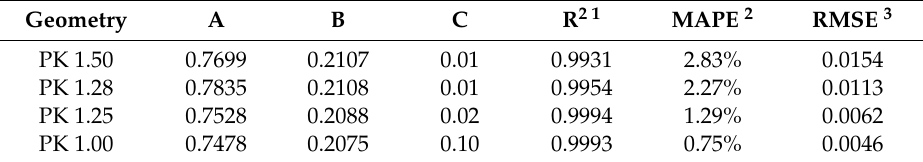
Table 3. Coe ffi cients corresponding to Equation (1) and values of R 2 , MAPE, and